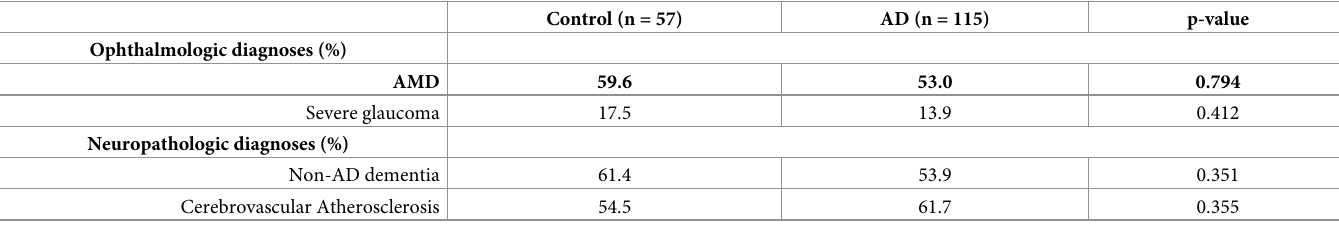
Table 2. Ophthalmic and neuropathologic diagnoses. Control (n = 57) AD (n = 115)